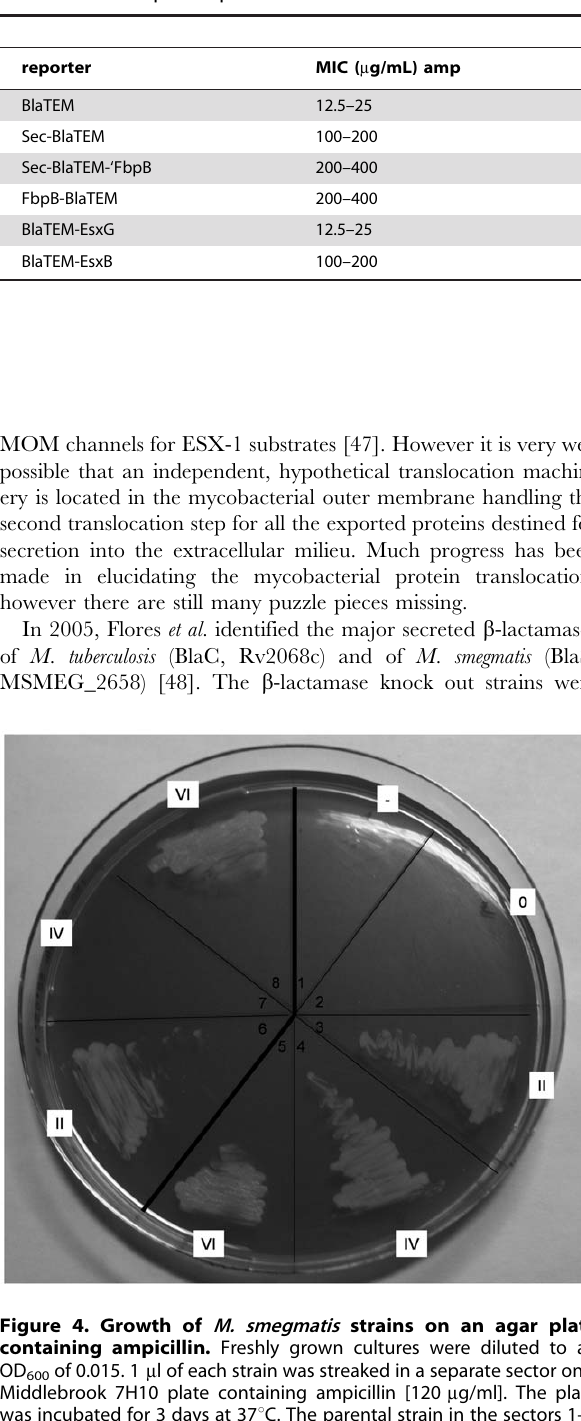
Table 2. Ampicillin MIC of M. smegmatis D blaS D eccD 3 strains with or without reporter plasmid.